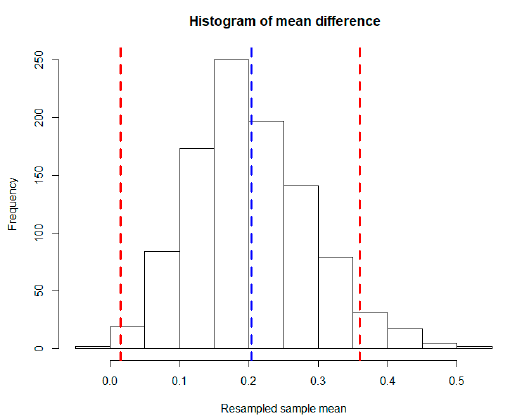
Figure 9. The distribution of mean difference of toxin level after reference treatment and new treatment during the bloom months (June–October 2014).